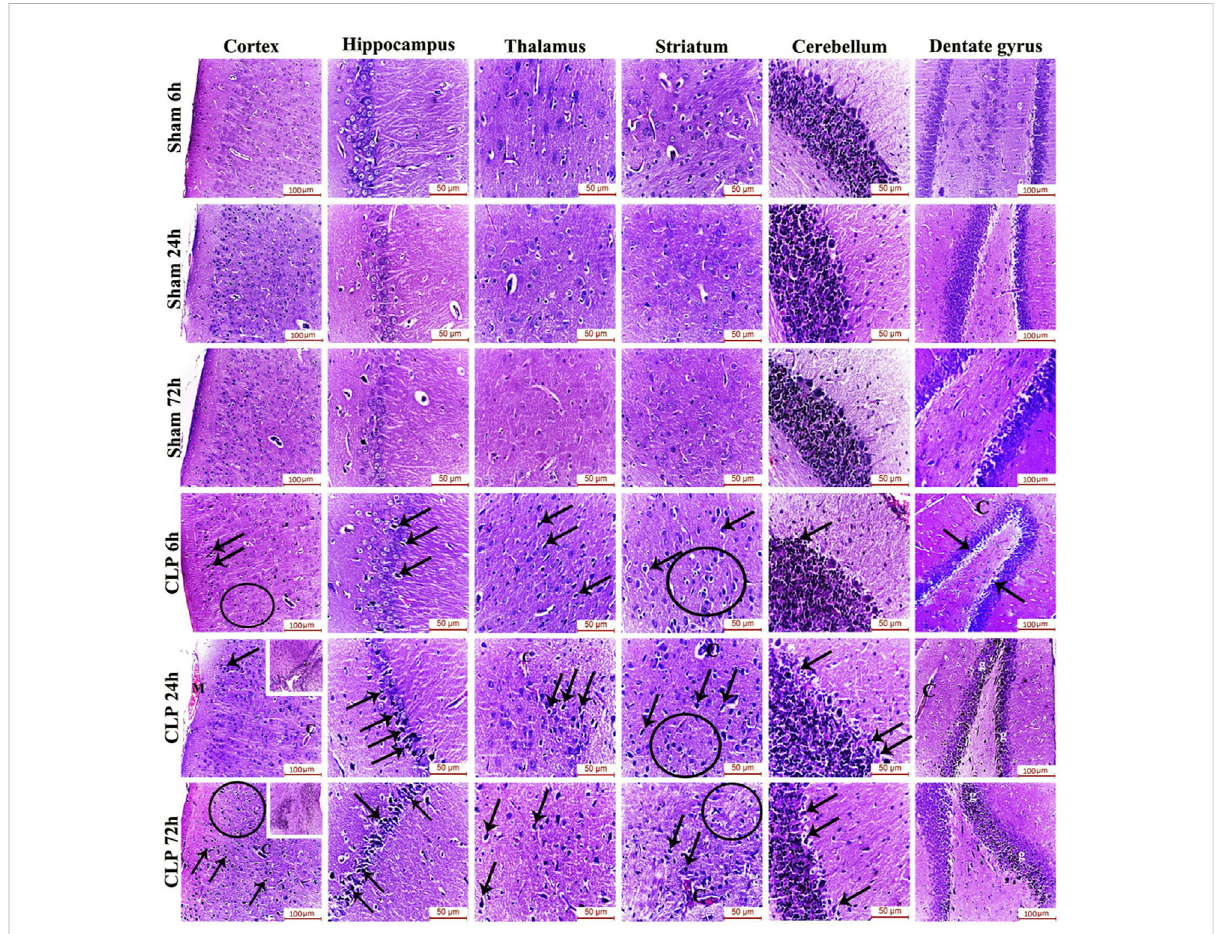
FIGURE 2 Sepsis-induced encephalopathy enhanced microgliosis and neuronal degeneration. H&E-stained sections of the different brain regions showing darkly-degenerated, apoptotic neurons (arrows) and glial cell proliferation (circles). The dentate gyrus shows marked microgliosis (g). The insets in the cerebral cortex show a picture of subependymal microgliosis in the CLP 24 h groups, and foci of focal cortical microgliosis in the CLP 72 h groups. Meningeal congestion (M) is also observed in the cerebral cortex of the CLP 24 h group. The blood capillaries (C) exhibit interruption of their endothelial lining with widening of Virchow Robin ’ s (perivascular)